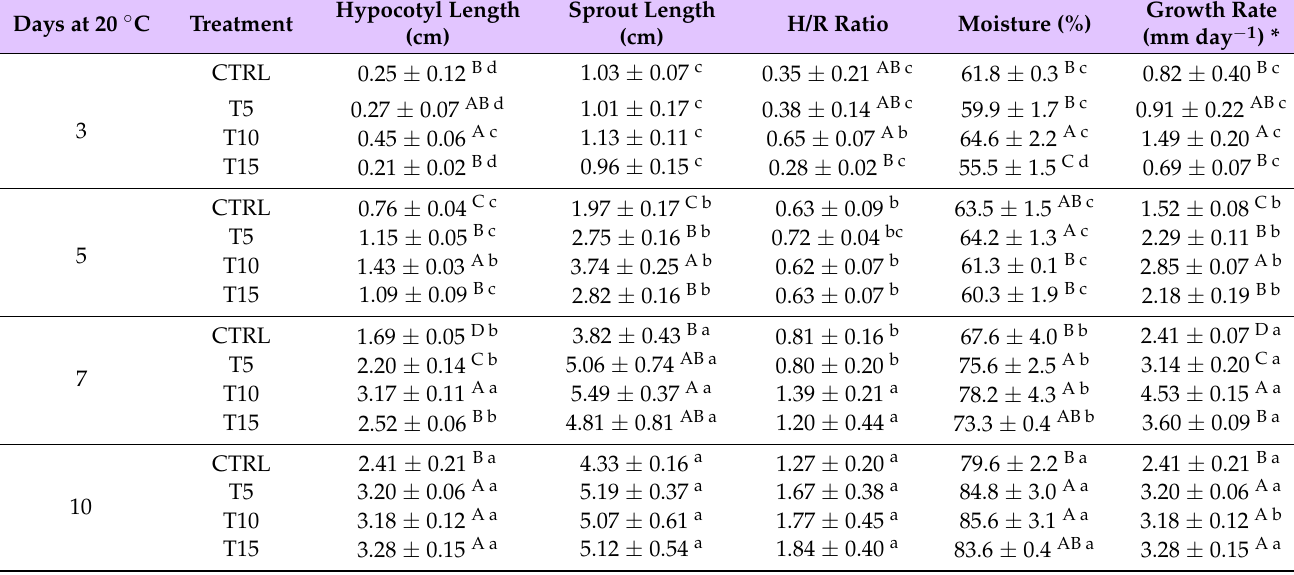
Table 1. Morphological characteristics of UV-B treated (0 -CTRL-, 5, 10, and 15 kJ m − 2 ) red cabbage sprouts during 10 growing days at 20 ◦ C.